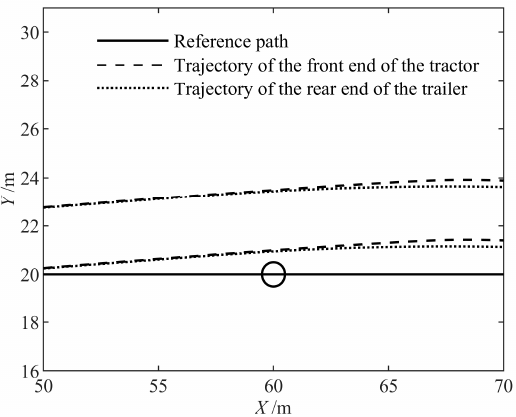
Figure 16. Partially enlarged view of Figure